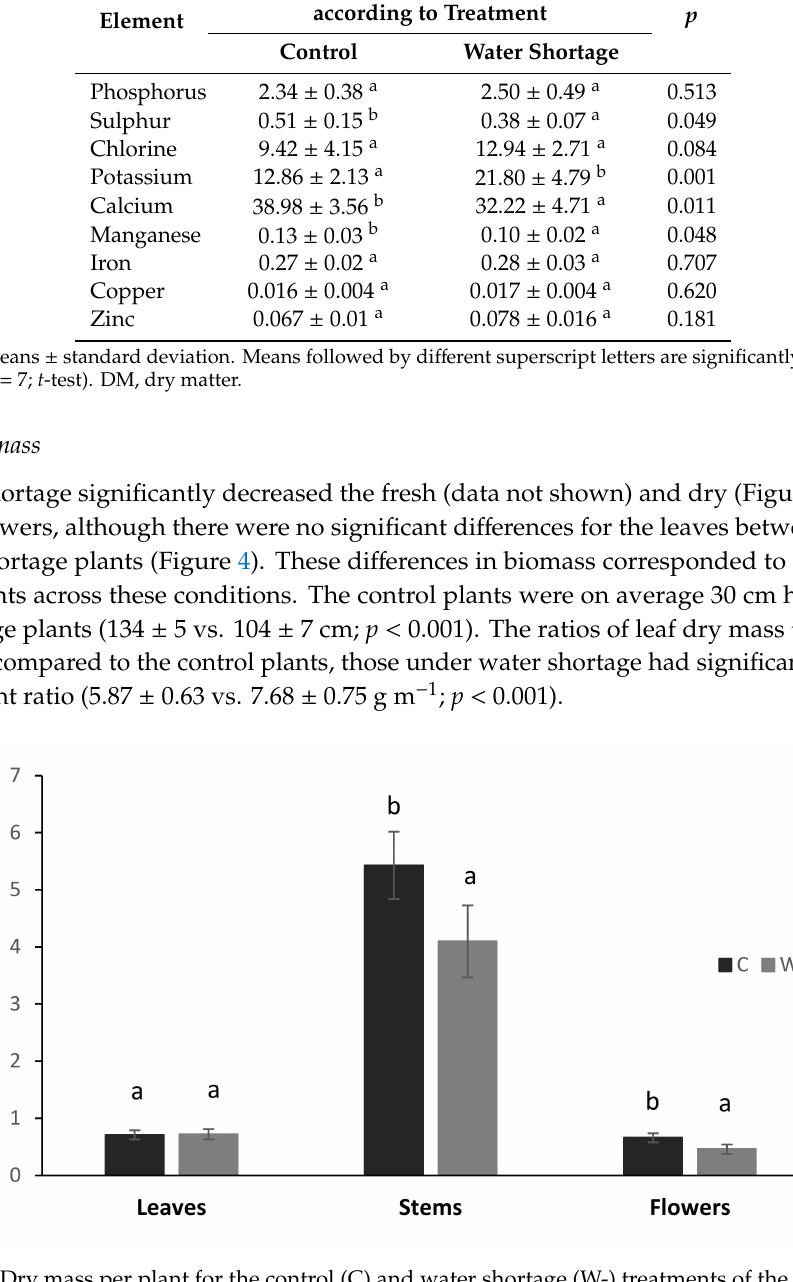
Figure 4. Dry mass per plant for the control (C) and water shortage (W-) treatments of the buckwheat plants. Data are means ± standard deviation ( n = 7). Di ff erent letters indicate significant di ff erences between treatments within each plant part ( p ≤ 0.05; t